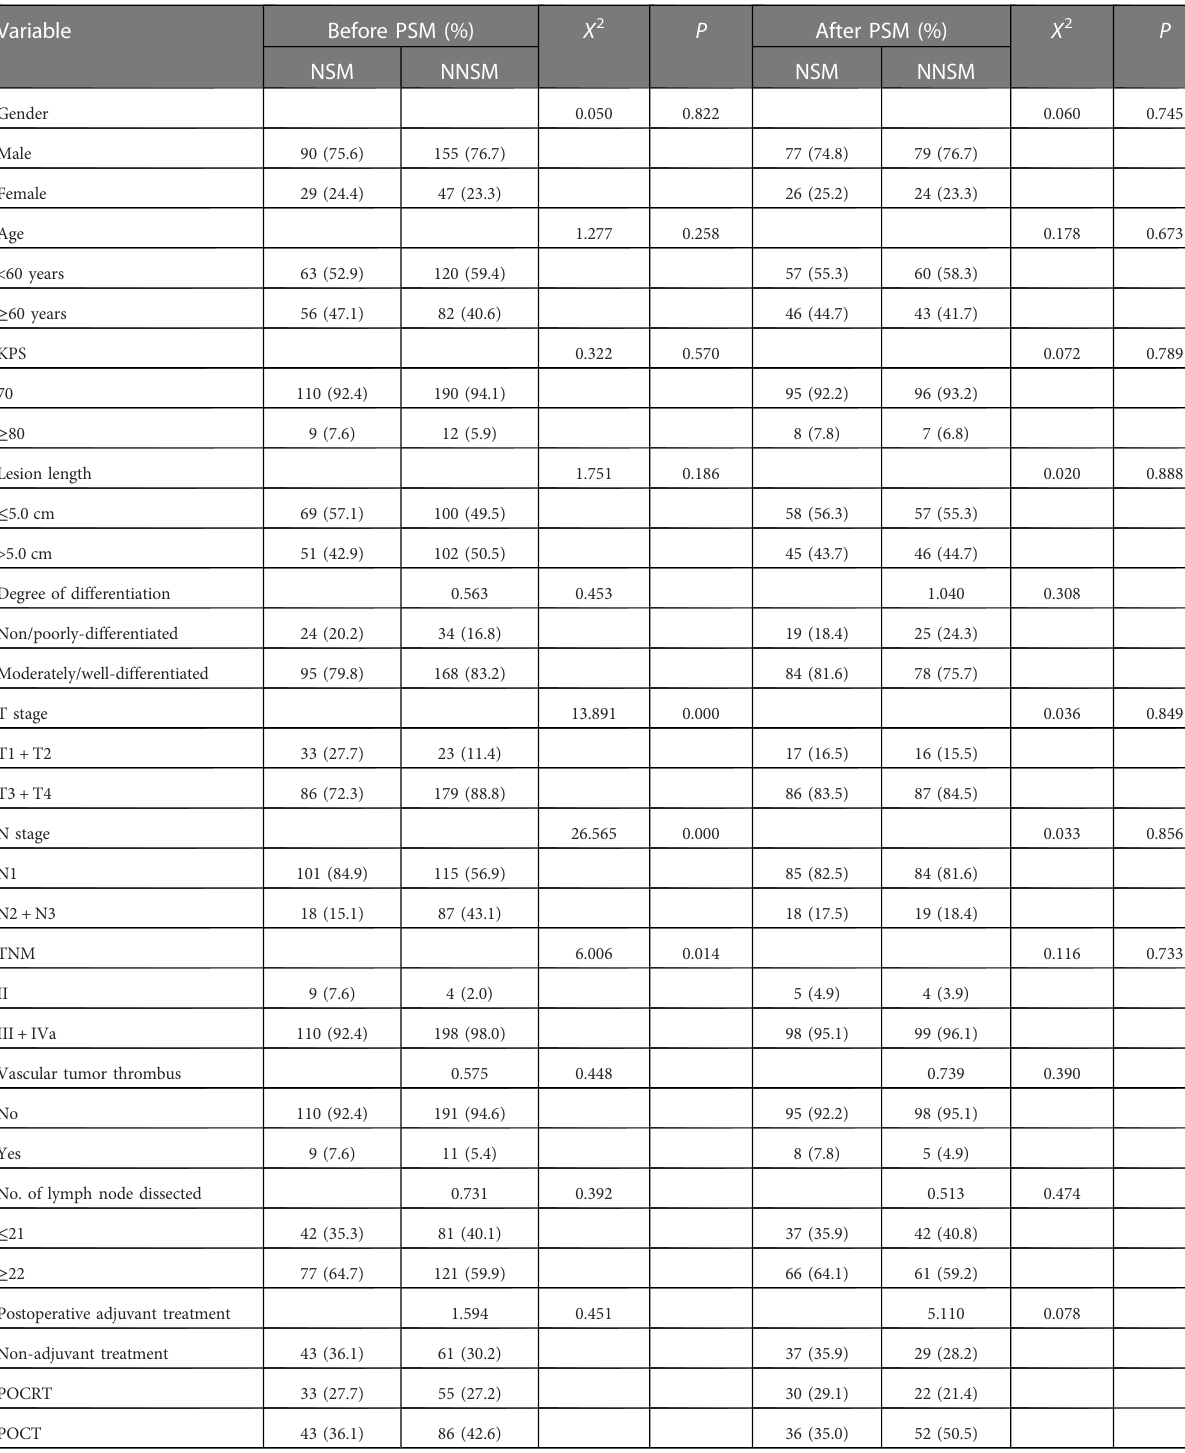
TABLE 1 Analysis results of the composition ratio of general clinical and pathological indicators of patients before and after